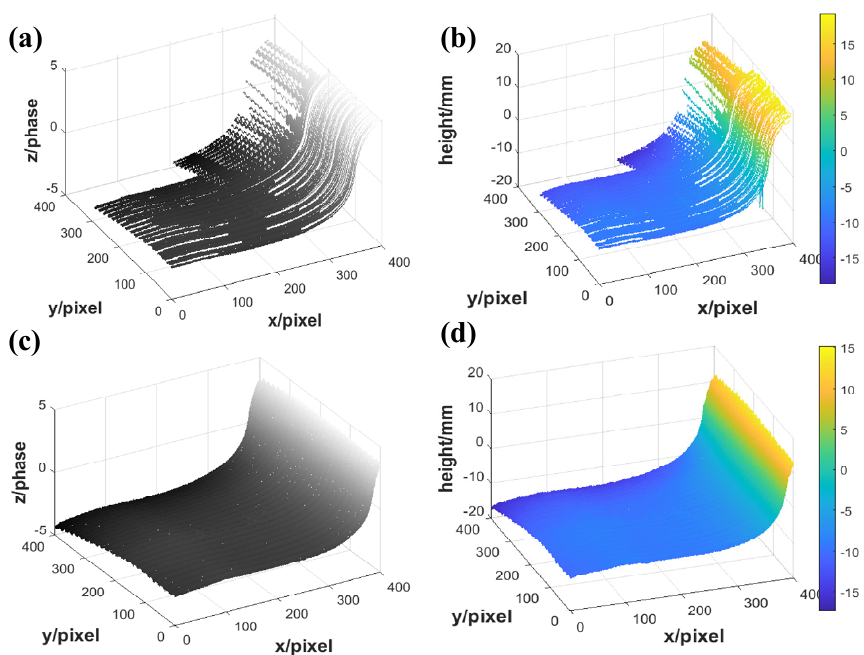
Figure 4. Unwrapped phase and reconstruction of ( c ) in Figure 3: ( a , b ) using traditional Stoilov algorithm; ( c , d ) using improved Stoilov algorithm.